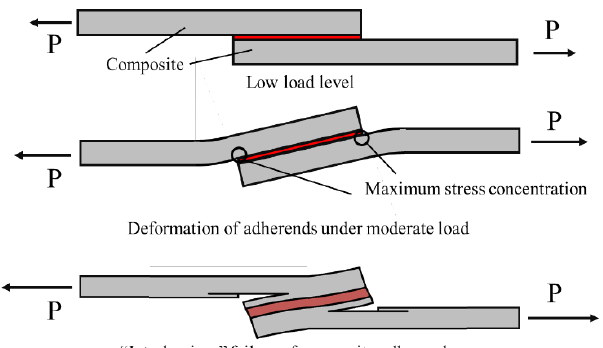
Figure 1. Effect of load level on the deformation and interlaminar failure of the composite ad- herends.